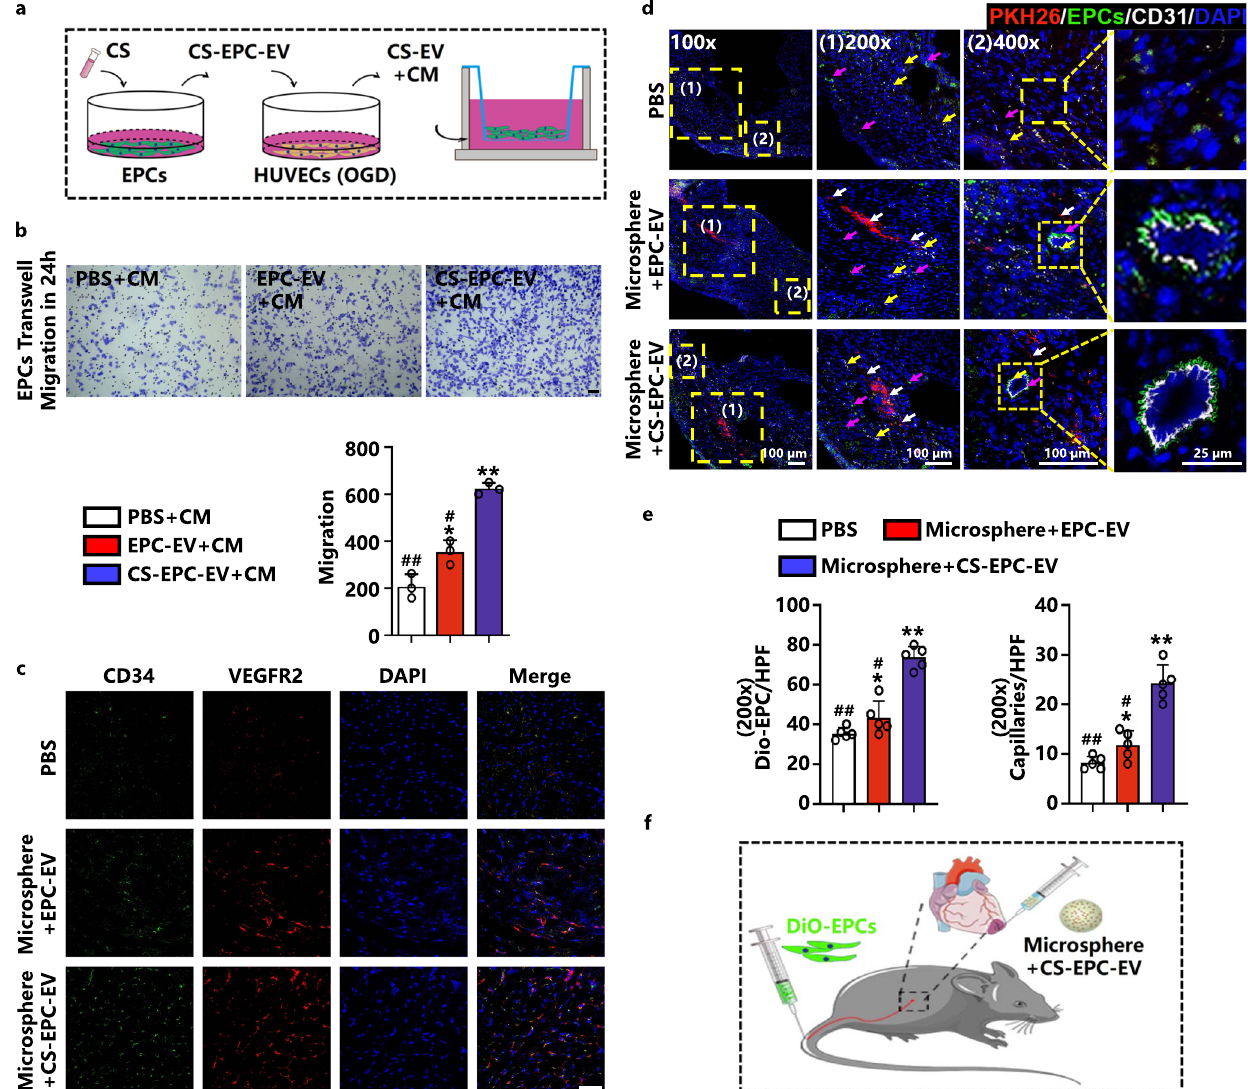
fl uorescence, purple arrow), CD31 (white fl uorescence, yellow arrow), and DAPI (blue fl uorescence) ( n =5, biological replicates per group). e Quantitative analysis of DiO-EPCs and th e number of capillaries in the peripheral area of myocardial infarction (200 x magni fi cation). * p <0.05, ** p <0.01 vs. the PBS group; # p <0.05, ## p <0.01 vs. microsphere+CS-EPC-EVs ( n =5, biological replicates per group). f Schematic diagram of the DiO-EPCs injection and microsphere+CS-EPC-EV treat- mentofin f arctednudemice.ThisFigurewascreatedwithBioRender.com.Dataare presentedasthemean±standard.Two-tailedStudent ’ s t -testwasusedtocompare the differences between two groups. One-way ANOVA and post hoc Bonferroni testswereusedto compare differencesamong morethantwogroups.Source data are provided as a Source Data fi le. Each experiment was repeated 3 times or more independently with similar